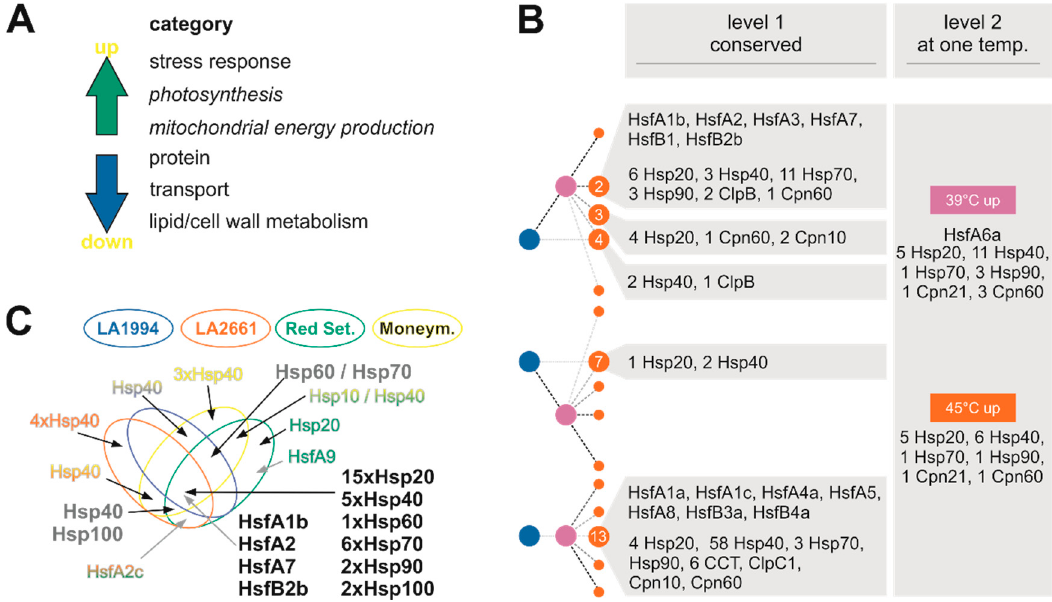
Figure 9. Hallmarks of the common response of tomato in response to elevated temperatures. ( A ) The categories enriched in upregulated or downregulated genes are shown. ( B ) The distribution of gene coding for heat shock proteins or the heat shock transcription factors in the different categories in Figure 3C is shown. ( C ) The distribution of gene coding for heat shock proteins or the heat shock transcription factors in the Venn diagram presented in Figure 3B is shown. Genes found in three species are shown in dark grey, genes shown in all species are shown in black, the others are color coded according to their occurrence.